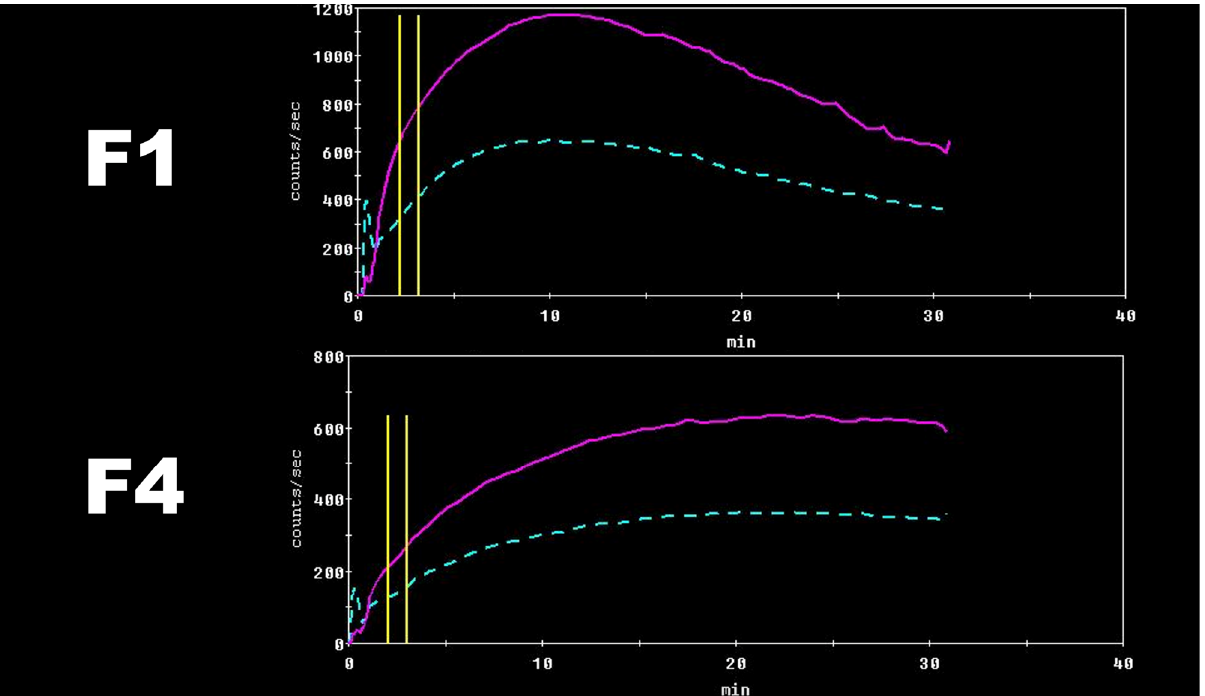
Figure 4. Two HCV patients, the first with F1 and the second with F4 fibrosis. There are clear differences between the tracer dynamics, including tracer acceleration (SLOPE, TTP) and excretion (30/peak). Calculated liver clearance was also different–F1 LCL_m 2 10.51%/min/m 2 , LCL_m 2 _dm 2 – 5.41%/min/m 2 /dm 2 and F4 LCL_m 2 4.64%/min/m 2 , LCL_m 2 _dm 2 –1.78%/min/m 2 /dm 2 .